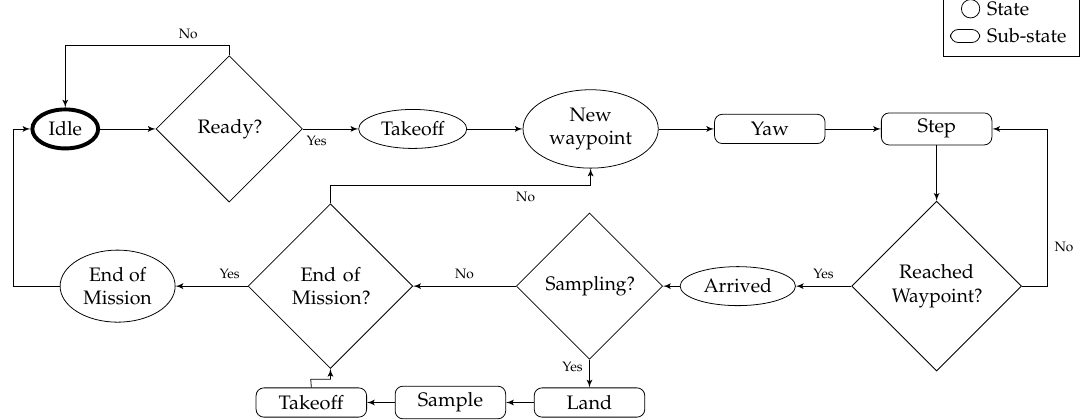
Figure 5. Software flowchart of the flight control algorithm on the on-board computer. Sub-states are actions that are triggered between 2 states to enable a transition to the next state. The UAV is in an IDLE state at the beginning of the